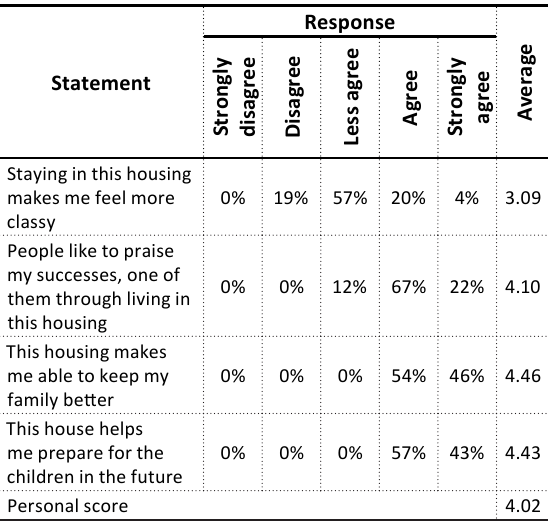
Table 13. Personal construct descriptive